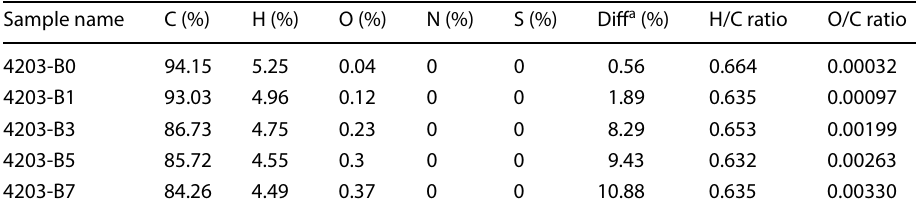
Table 3 Elemental analysis of boric acid-added